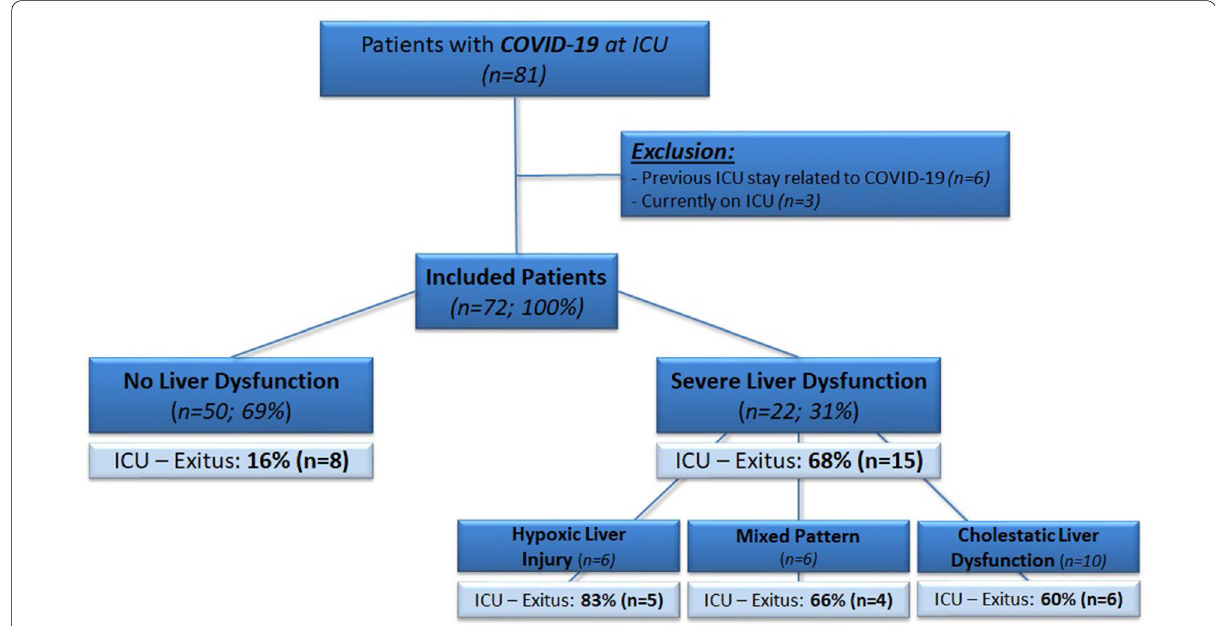
Fig. 1 Flowchart of the